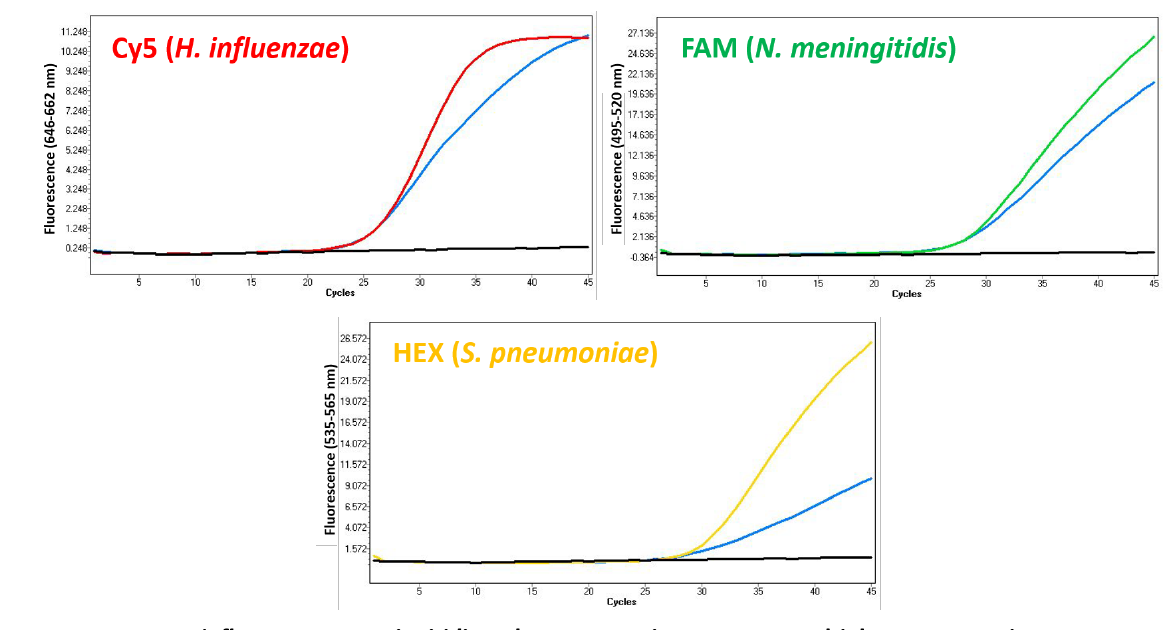
Figure 4. 3TEC-PCR multiplex detection. The H. influenzae , N. meningitidis , and S. pneumoniae 3TEC-PCR multiplex assay was challenged with type strain genomic DNA from all three bacterial targets at 10 4 genome copy concentrations, in separate reactions and in one combined reaction. Resulting amplification fluorescence was recorded with the LightCycler 480 Instrument II using the Cy5, FAM, and HEX fluorescence detection channels. Each bacterial target tested in sepa- rate reactions was successfully detected in the appropriate corresponding detection channel: H. influenzae in Cy5 (red), N. meningitidis in FAM (green), and S. pneumoniae in HEX (yellow), with no non-specific detection observed. The successful simultaneous detection of all three bacterial targets in a single reaction was also observed (blue). The negative control reaction performed successfully as no signal generation was observed